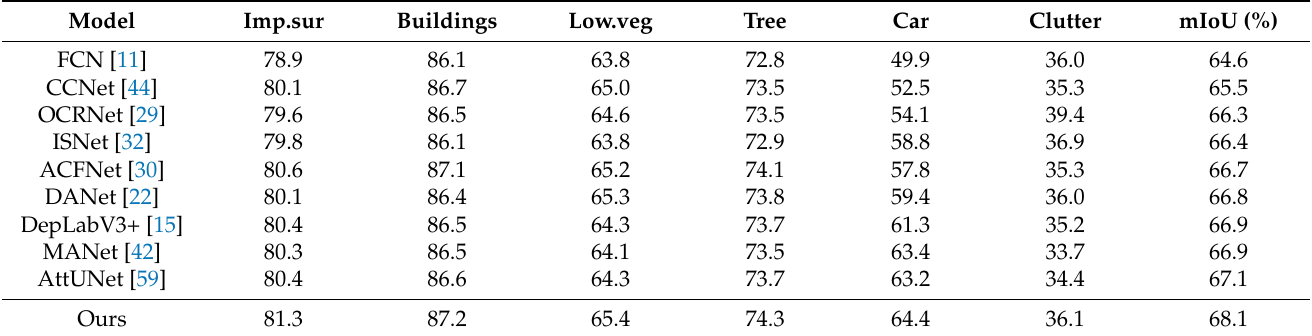
Table 8. Per-class results (mean intersection over union) on the Vaihingen test set.